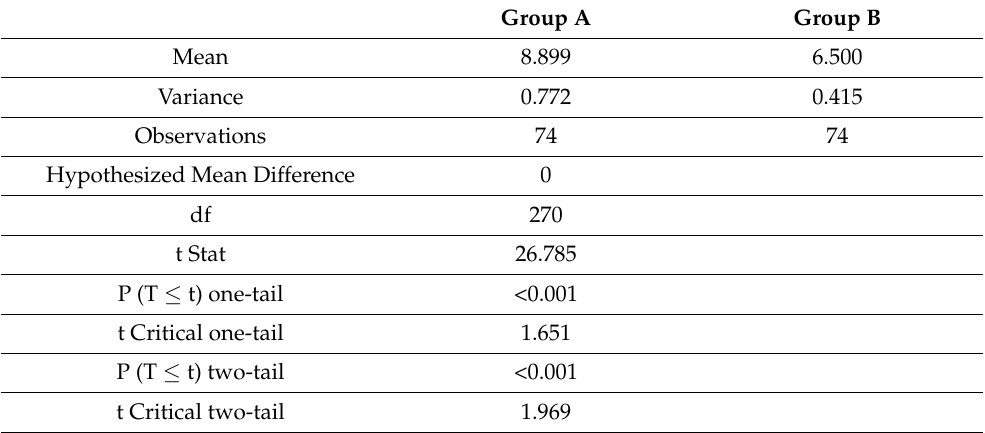
Table 5. t -test results of Q2.